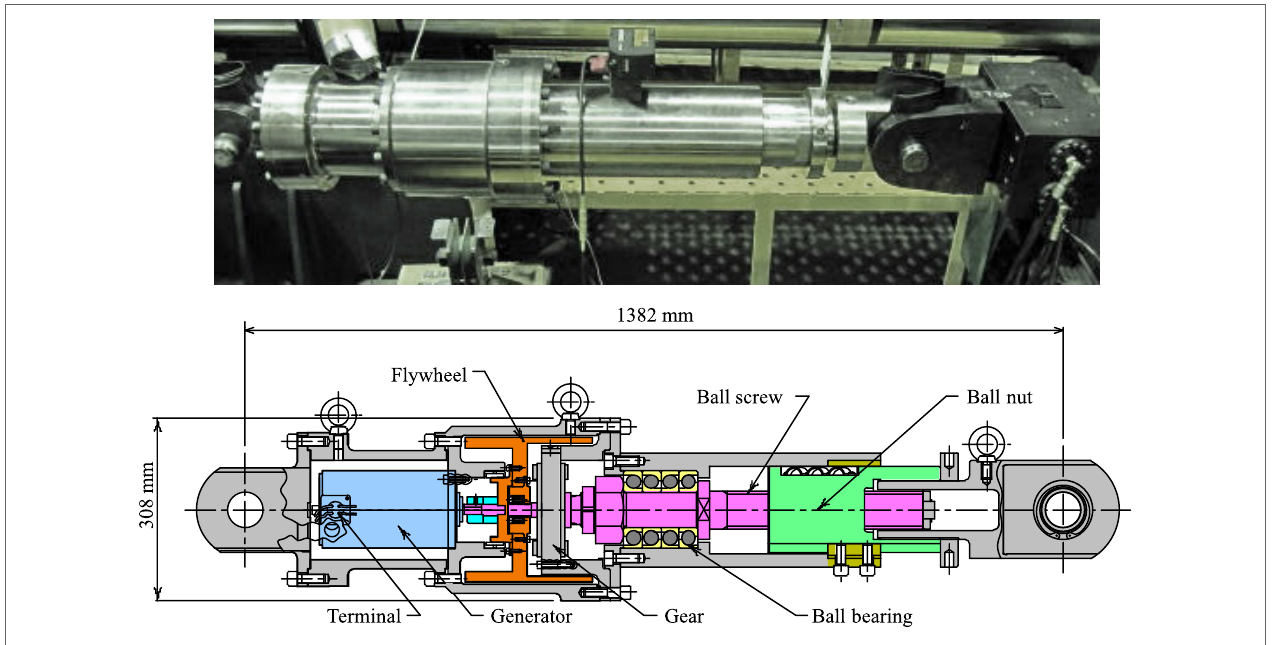
FIGURE 2 | Photograph and schematic of the electromagnetic inertial mass damper .